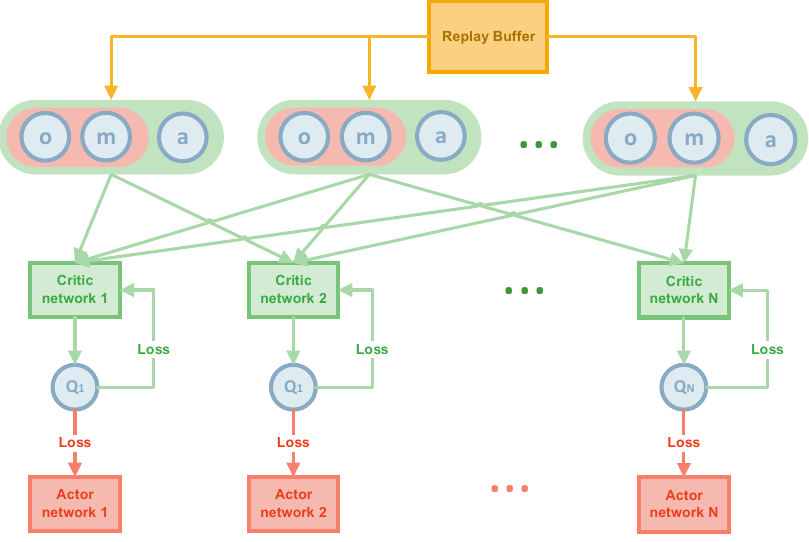
Figure 2. The training process of MATSMI.